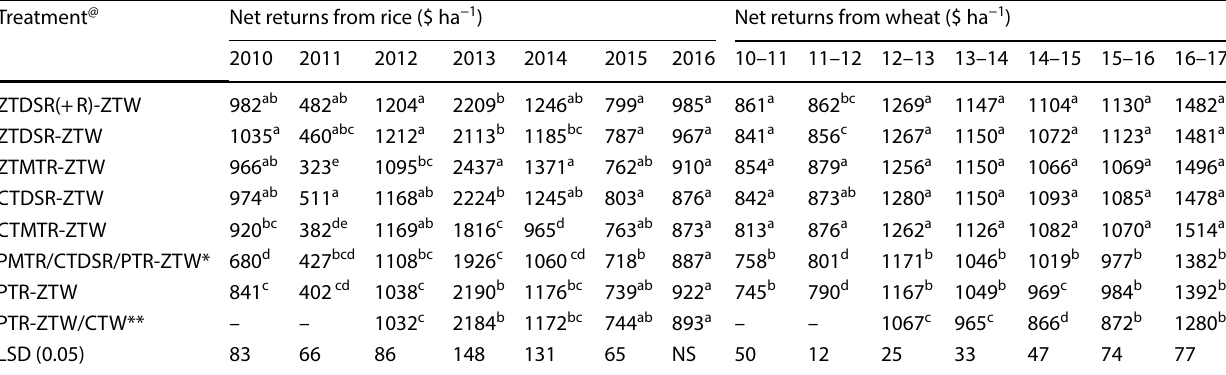
Table 4 Net economic returns over variable cost from rice and wheat crops under different crop establishment methods in the rice–wheat cropping system